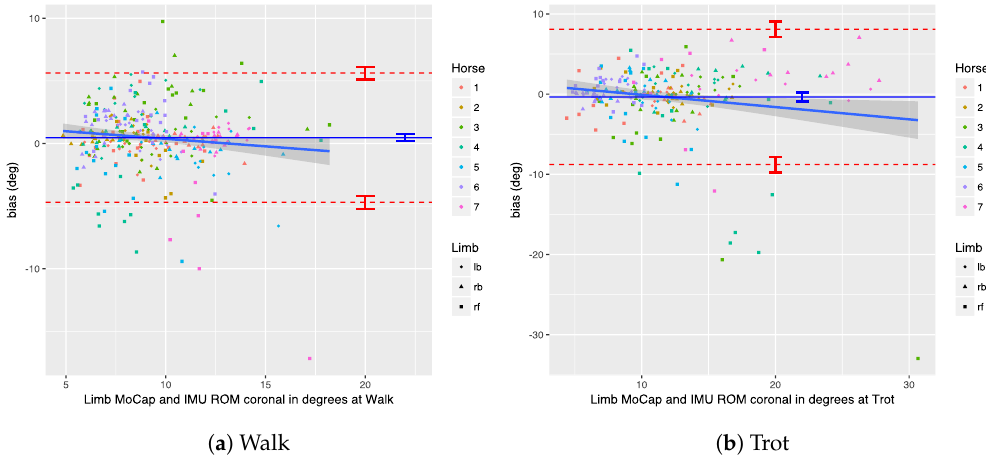
Figure 24. Bland–Altman analysis for coronal ROM at walk and